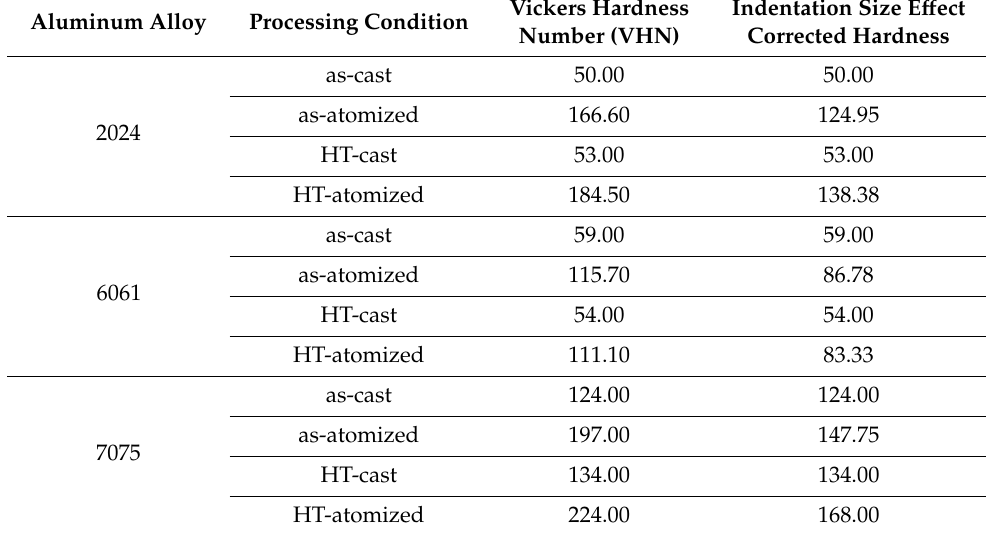
Table 6. The Vickers Hardness Numbers (VHNs) for each of the alloys in all four conditions are presented herein. In the case of nanoindentation-derived VHNs, the indentation size e ff ect-inspired corrections were implemented to ensure accurate and direct comparison between bulk hardness values and powder